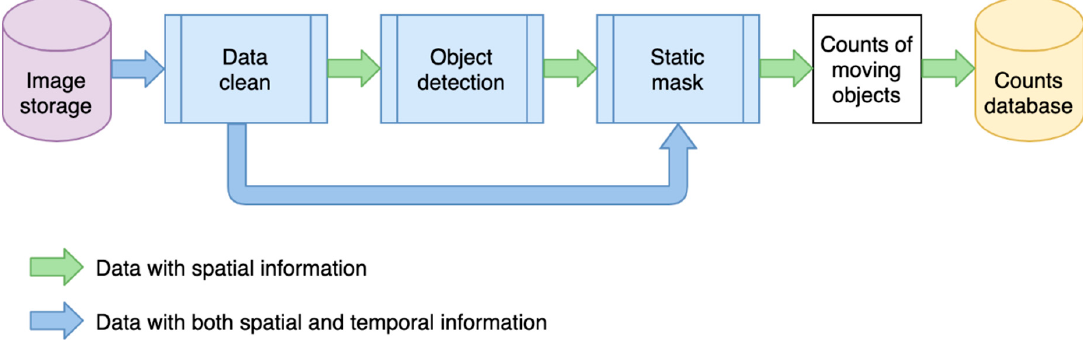
Figure 6. Data flow of the modeling process.